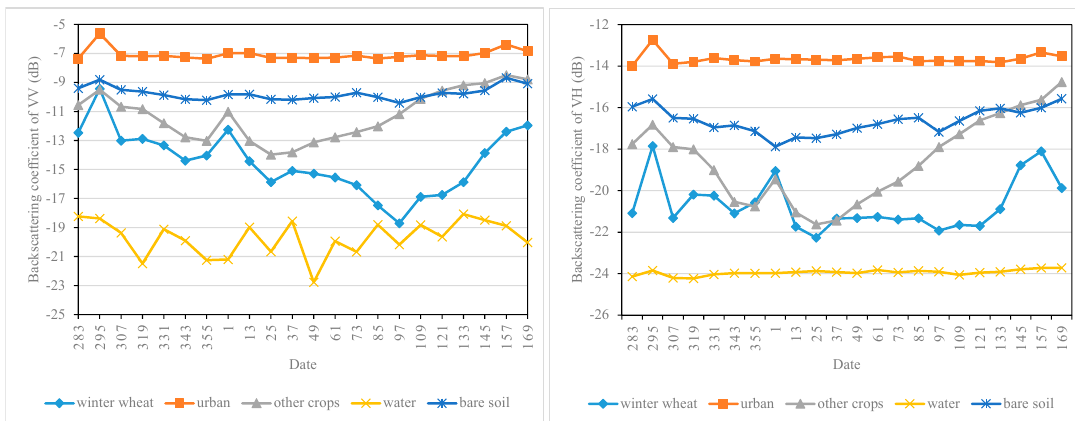
Figure 4. Temporal backscatter profiles of different land cover types (winter wheat, urban, other crops, water, and bare soil). The results showed the curve changes of σ vv ( left ) and σ vh ( right ) selected from ROIs during the growth stages of winter wheat from 9 October 2016 to 30 June 2017.